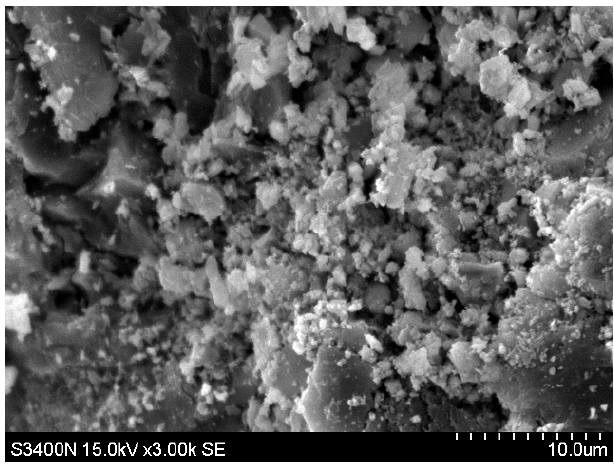
Materials 2021 , 14 , 832 Figure 14. Microstructure 5 mm below the inner coating of the substrate (3000×). Figure 14. Microstructure 5 mm below the inner coating of the substrate (3000 × ).